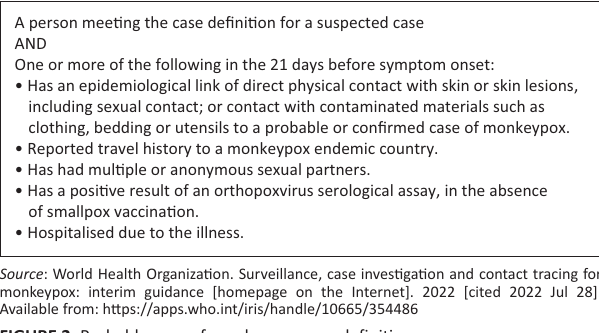
FIGURE 2: Probable case of monkeypox case